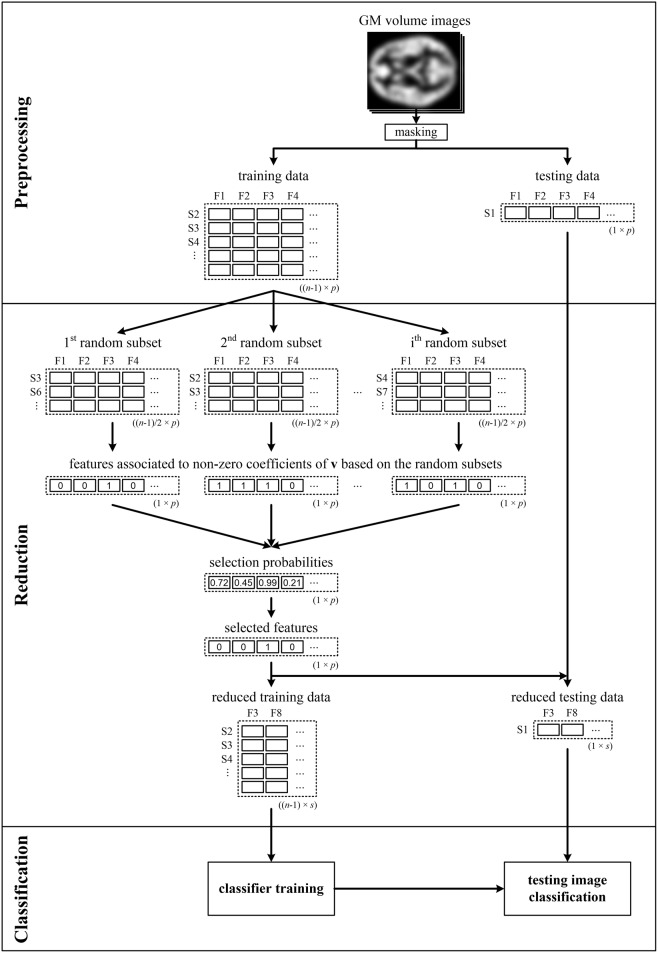
Illustrative scheme of recognition of patients from controls comprising LOOCV during data reduction and classification—LOOCV(rc). Brain images (e.g., GM volume images), from which the background and non-brain areas are removed using a binary mask, are split into training and testing sets. The training data are used to calculate the selection probabilities of features using pLDA based on random subsets. The training and testing data are then reduced by selecting only the features with selection probabilities ≥0.99. Next, the reduced training data are used to train the classifier, which makes it possible to classify the testing data into a group of schizophrenia patients or HC. The entire process is repeated n times as each image is sequentially chosen as the testing image.